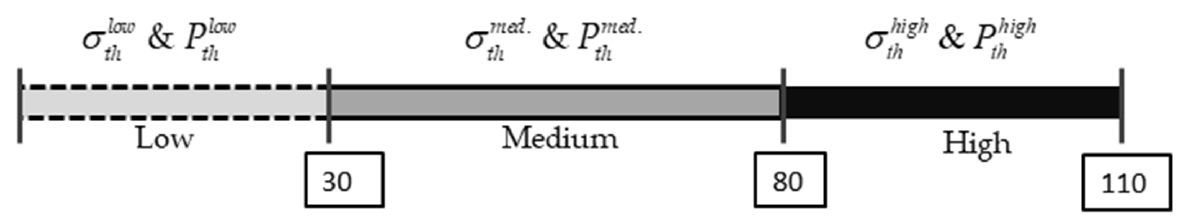
Figure 2. Scale for choosing the uncertainty threshold (the figure is not drawn to scale).